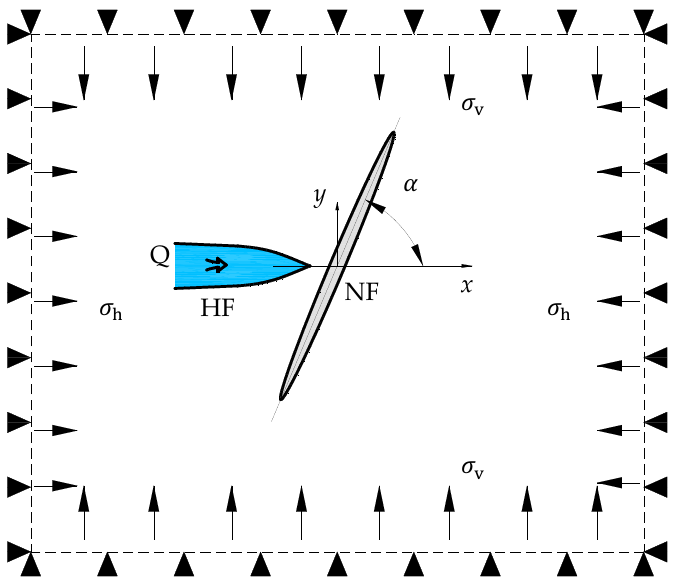
Figure 9. Schematic of intersection between the hydraulic fracture (HF) and the natural fracture (NF). Table 2. Parameters of the fracture crossing problem.